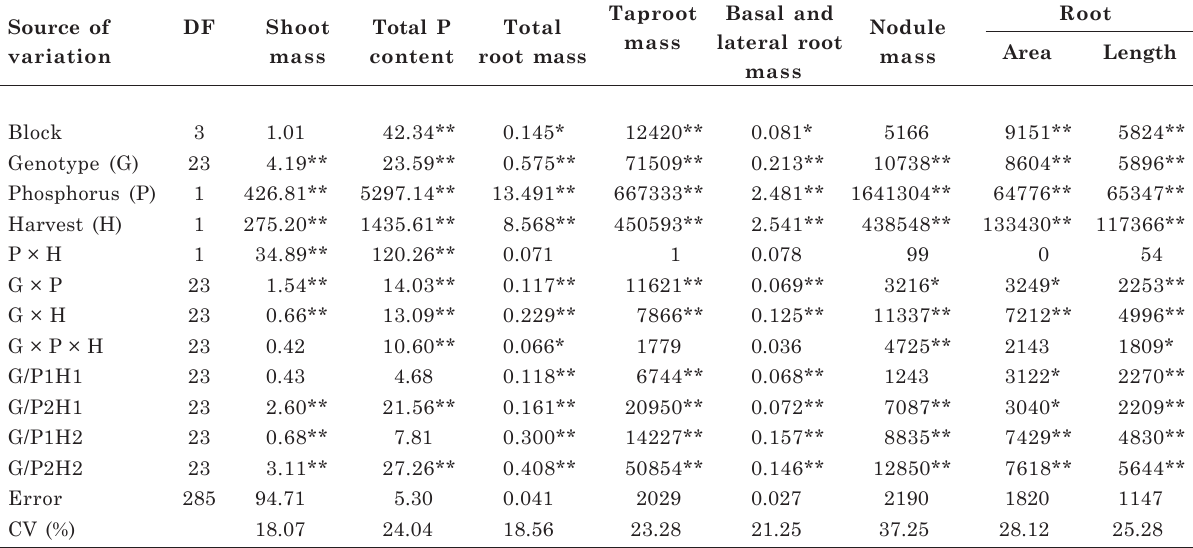
* and **: significant at 5 and 1 %, respectively, by F